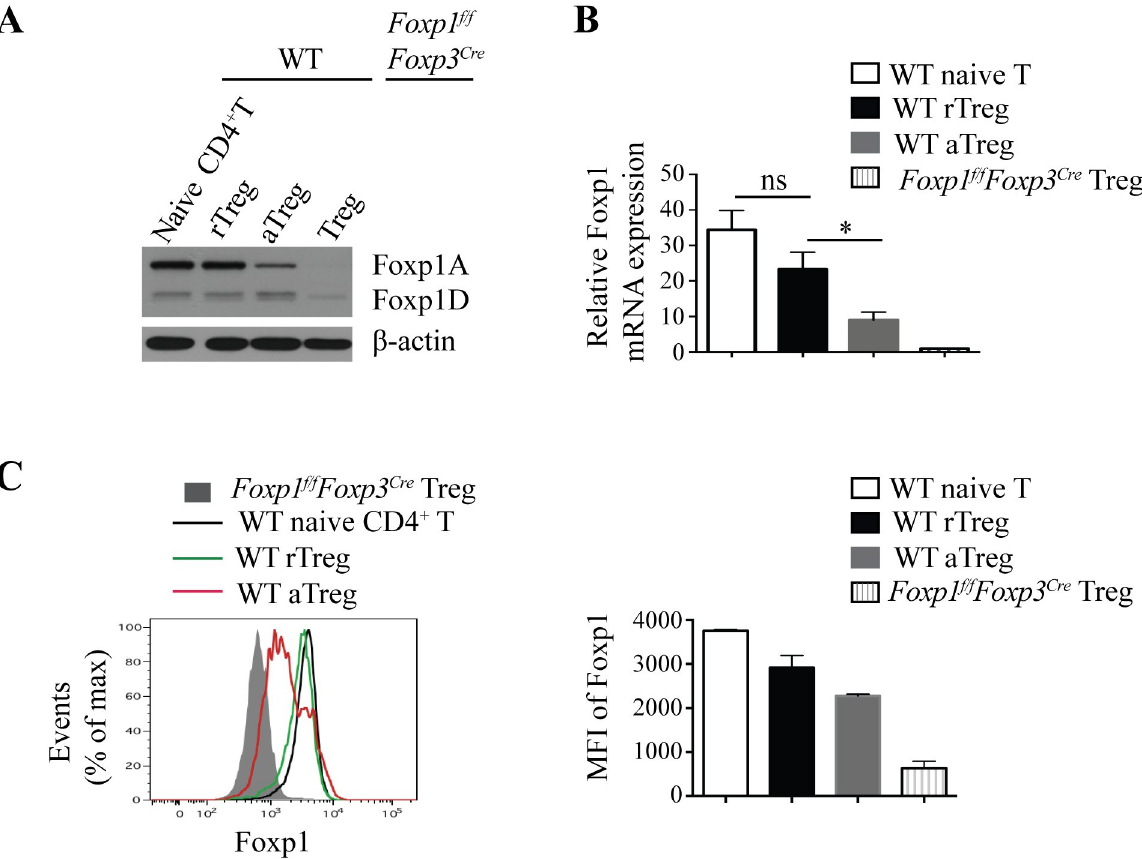
Fig 1. Foxp1 is differentially expressed in rTreg and aTreg cells. (A) Immunoblot analysis of Foxp1 expression in sorted YFP − CD4 + CD44 low CD62L high naive CD4 + T cells (WT naive), YFP + CD4 + CD44 low CD62L high rTreg cells (WT rTreg), YFP + CD4 + CD44 high CD62L low aTreg cells (WT aTreg) from Foxp3 Cre mice, and YFP + Treg cells from Foxp1 f/f Foxp3 Cre mice. (B) Relative Foxp1 mRNA expression in sorted WT naive CD4 + T cells, rTreg cells, aTreg cells from Foxp3 Cre mice, and YFP + Treg cells from Foxp1 f/f Foxp3 Cre mice, n = 3–4. (C) Intracellular staining of Foxp1 in splenic WT naive CD4 + T cells, rTreg cells, aTreg cells in Foxp3 Cre mice and splenic Treg cells in Foxp1 f/f Foxp3 Cre mice (left panel), and the corresponding mean fluorescence intensity (MFI) of Foxp1 (right panel) ( n = 2). Data in (A, C) represent at least two independent experiments. Data in (B) represent four independent experiments. Data in (B, C: right panel) are mean ± SEM. � P < 0.05 (two-tailed Student t test). Data associated with this figure can be found in the supplemental data file (S1Data) .aTreg, activated Treg; CD, cluster of differentiation; Foxp1, forkhead box P1; Foxp1A, Foxp1 isoform A; Foxp1D, Foxp1 isoform D; MFI, mean fluorescence intensity; rTreg, resting Treg; WT, wild-type; YFP, yellow fluorescent protein.